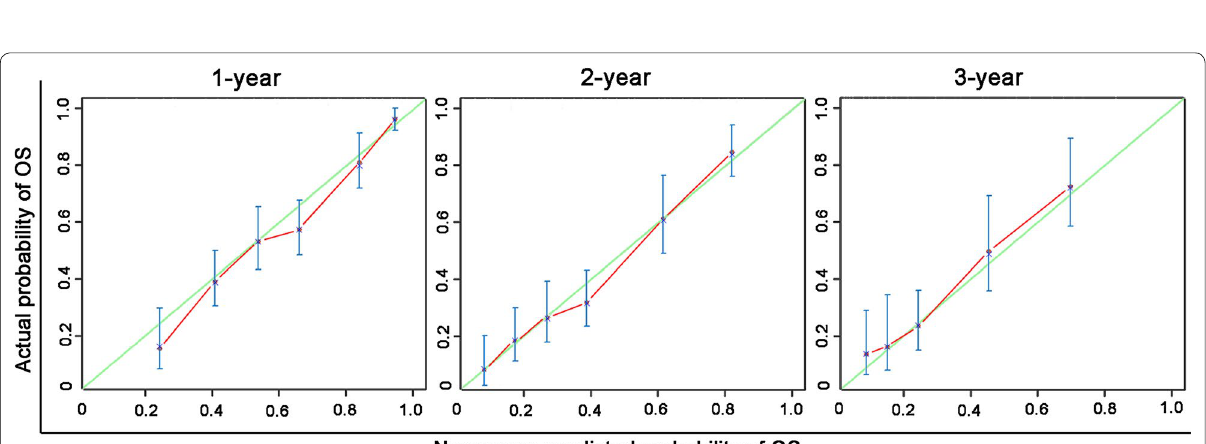
Fig. 3 Calibration plots of the nomogram for survival prediction in the study cohort. X ‑axis represents the nomogram‑predicted probability of survival; Y ‑axis represents the actual OS probability estimated using the Kaplan–Meier method. A perfectly accurate nomogram prediction model would result in a plot that the observed and predicted probabilities for given groups fall along the 45‑degree line. Dots with bars represent nomogram‑predicted probabilities along with 95% confidence intervals. These calibration curves showed good agreement between prediction